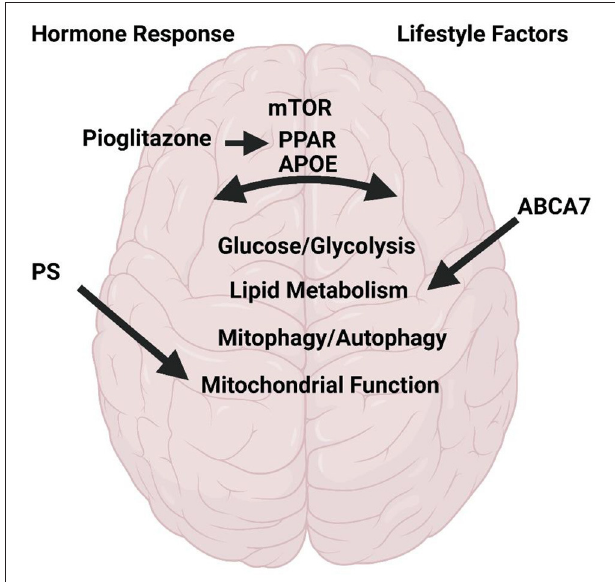
FIGURE 1 | Metabolism in Alzheimer’s Disease. Research and review articles discuss the role of hormone response to meals, lifestyle factors on brain function with respect to mTOR, PPAR, PS1, ABAC7, and APOE. All of which regulate glycolysis/glucose and lipid metabolism, mitophagy/autophagy, and mitochondrial function. Created with